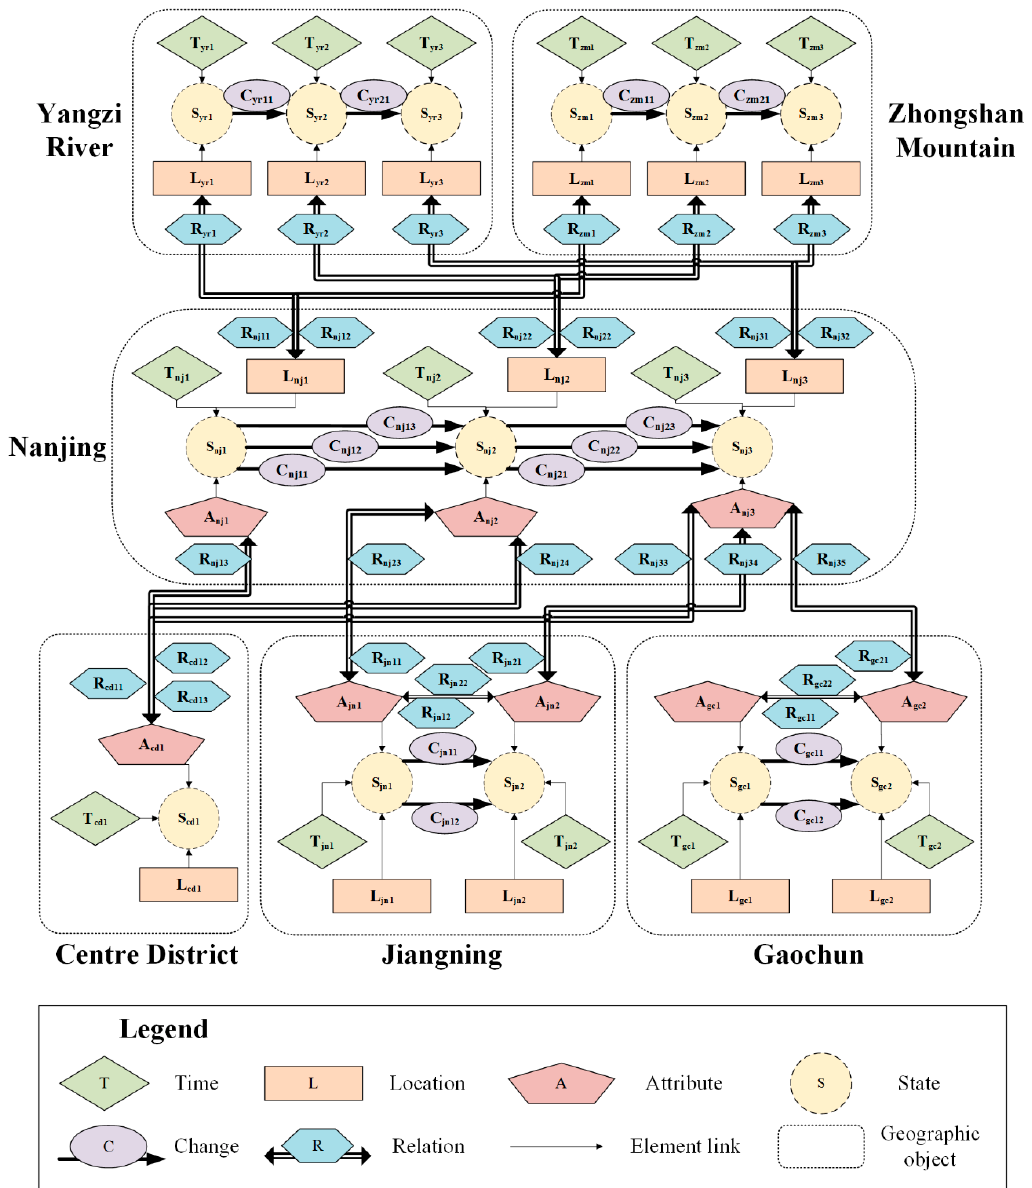
Figure 7. An overview of evolution case of administrative divisions of Nanjing and relevant geographic objects.